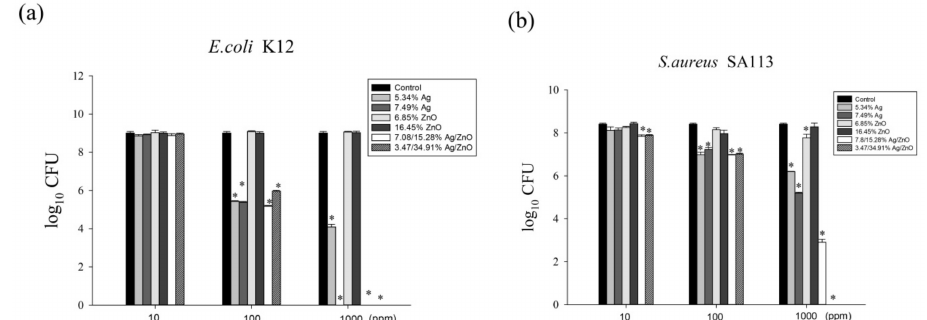
Figure6. Theantibacteriale ff ectsofAg / rGO,ZnO / rGOandAg / ZnO / rGOnanocomposites. ( a ) E.coli K12, ( b ) S. aureus SA113. Antibacterial e ff ects of 5.34% Ag / rGO (medium light gray), 7.49% Ag / rGO (medium dark gray), 6.85% ZnO / rGO (light gray), 16.45% ZnO / rGO (dark gray), 3.47 / 34.91% Ag / ZnO / rGO (diagonal bar), and 7.08 / 15.28% Ag / ZnO / rGO (white bar) at concentrations of 10, 100, and 1000 ppm, against Escherichia coli K12 and Staphylococcus aureus SA113 strains grown in MHB medium at 37 ◦ C. The control (black color) was without any treatment. Data are expressed as mean ± standard deviation of two separate experiments, with three replicates. Asterisk represents p <